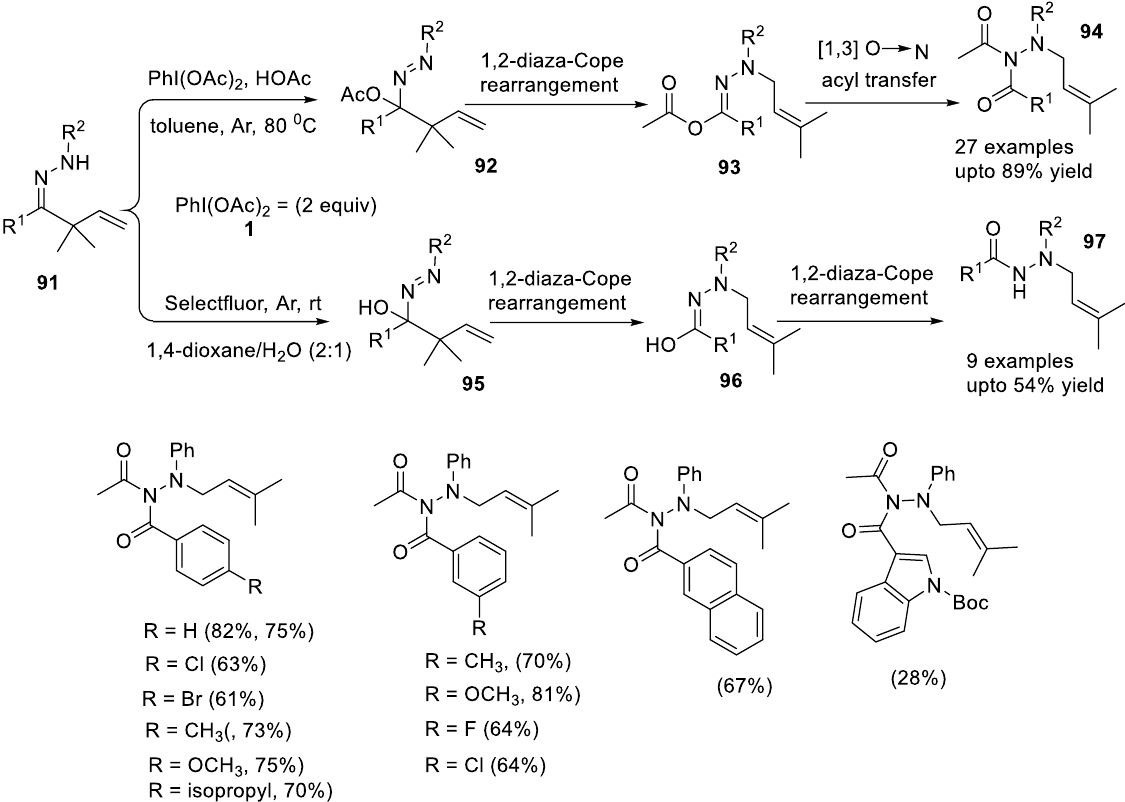
Scheme 15. PIDA-mediated 1,2-diaza-cope rearrangement